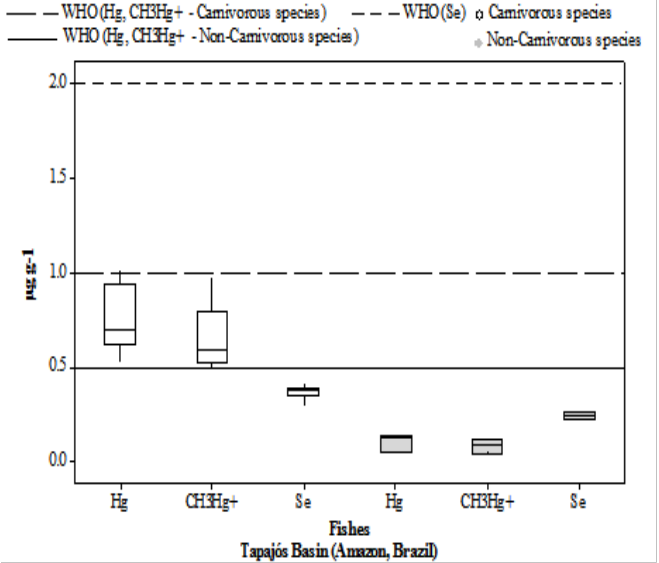
Figure 5: Hg, CH3Hg+ and Se concentration in fish species (Carnivorous and non-carnivorous).